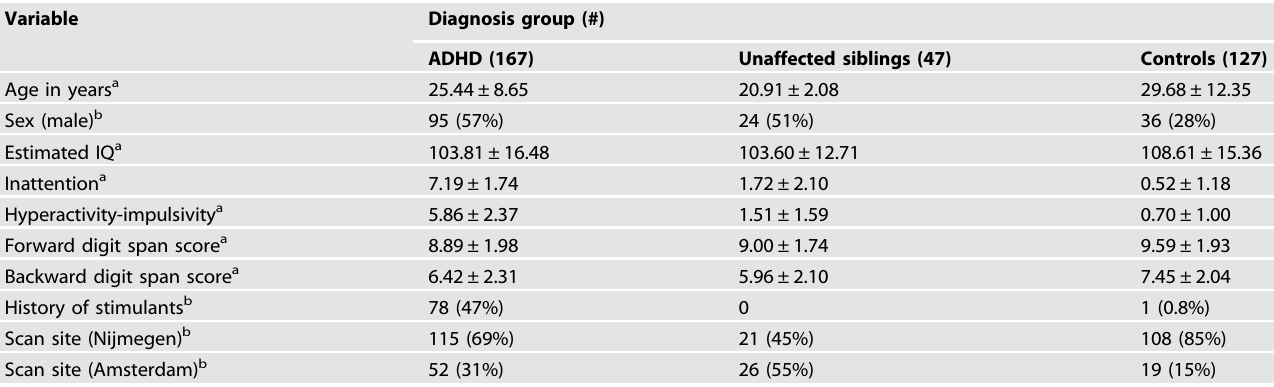
Table 1. Demographics and characteristics of the adult sample.